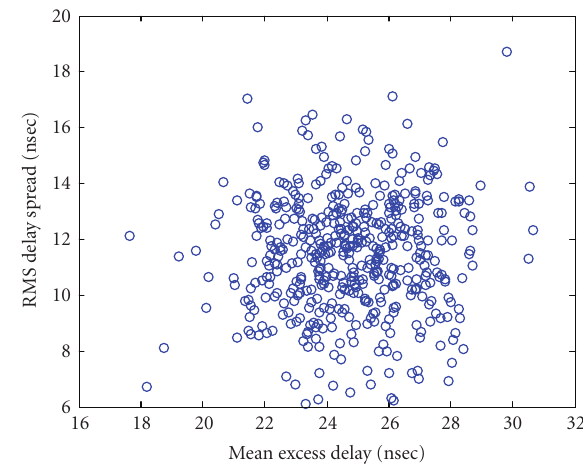
Figure 10: RMS delay spread versus distance, LOS (15dB thresh- old).